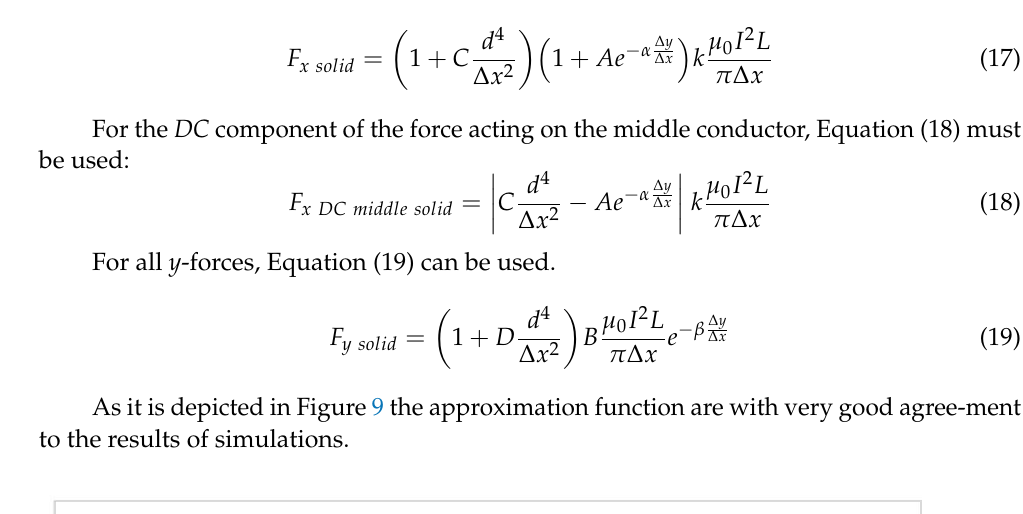
Figure 8. Simulation results and approximation function for stranded conductor. The analytical formulas for forces acting on the solid cables near the conductive plate were determined and expressed by Equations (17)–(19). For all x -forces except for the DC force acting on the middle conductor, Equation (17) can be used.